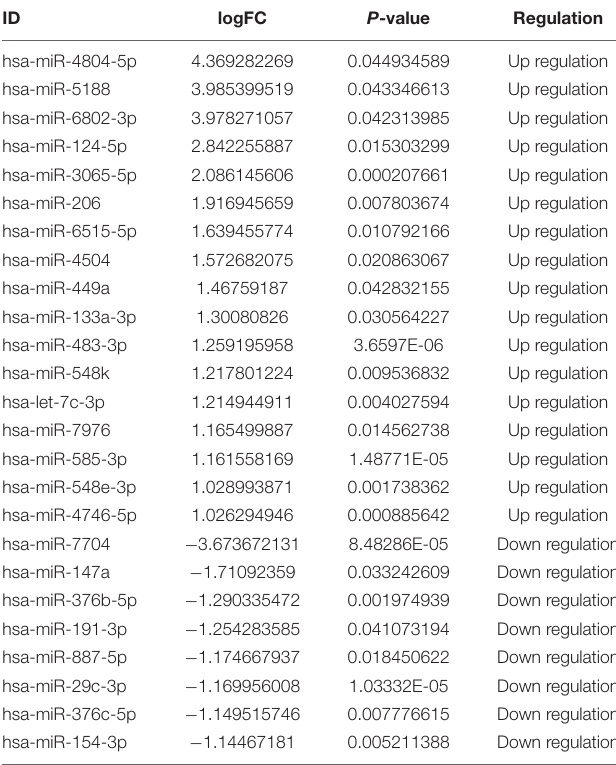
TABLE 2 | The differentially expressed miRNAs (DE-miRNAs) between inflammatory cells and inflammatory cells treated with